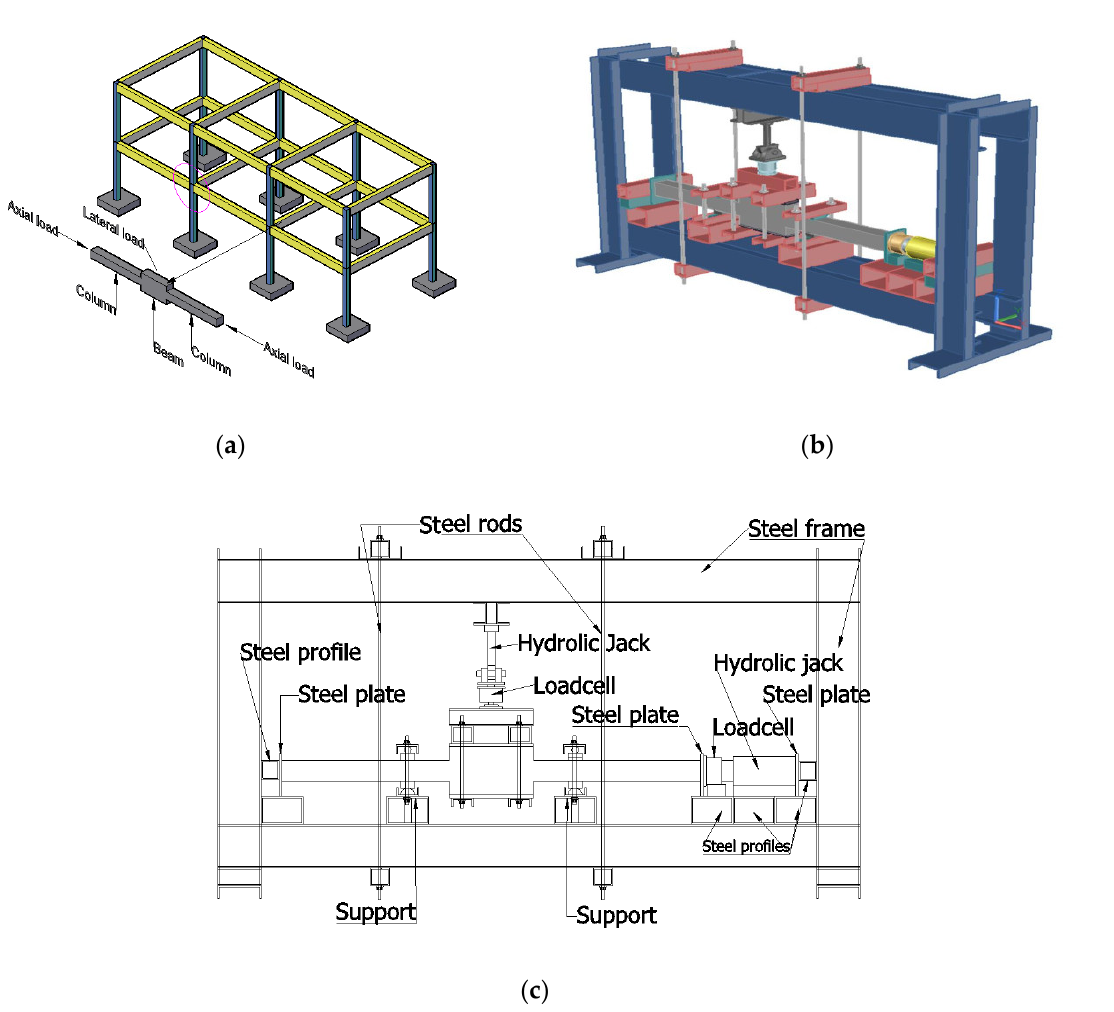
Figure 9. ( a ) Representative short-column specimen (rotated 90 degrees), ( b ) 3D view of the test setup, ( c ) 2D plan of the test setup.